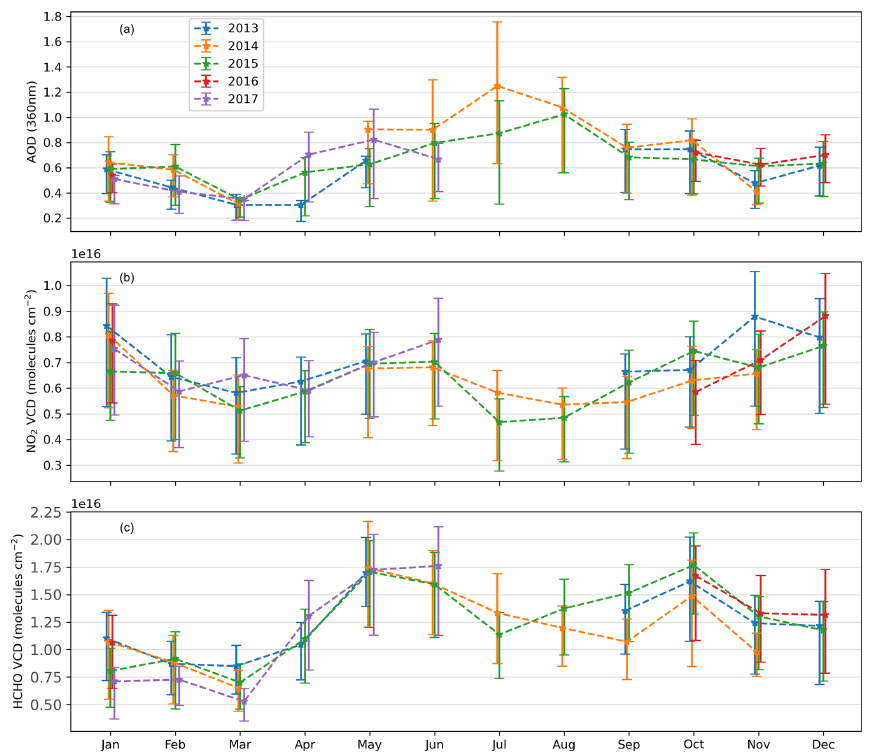
Figure 4. Monthly and annual variation in (a) AOD, (b) NO 2 , and (c) HCHO vertical column densities derived from MAX-DOAS measure- ments. The lower and upper vertical error bars represent the 25th and 75th percentiles,